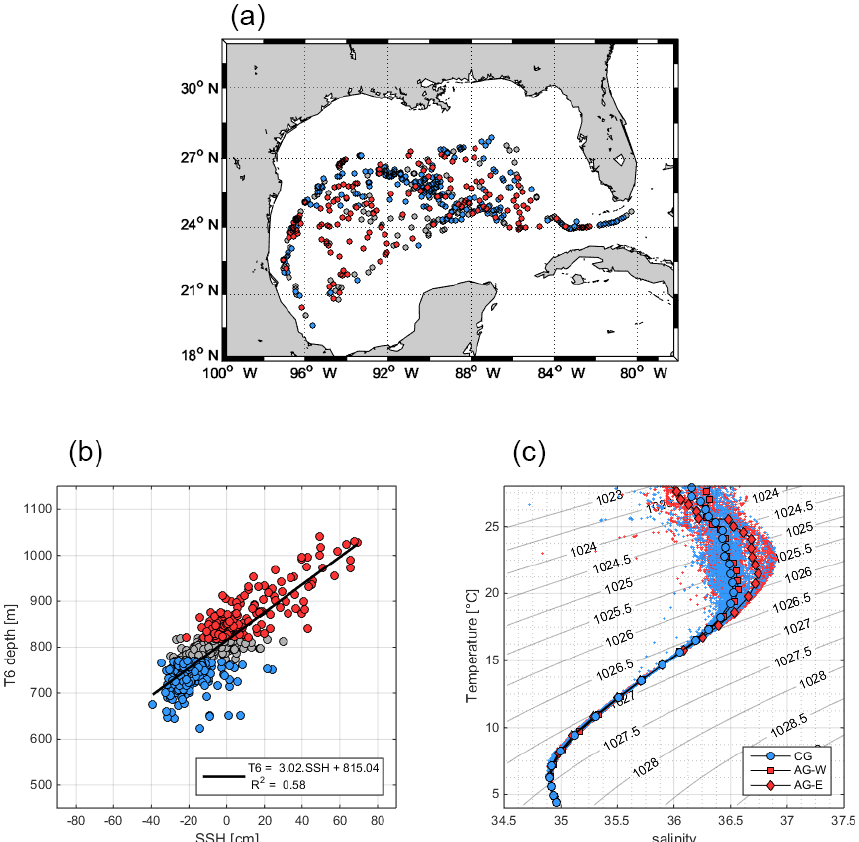
Figure 2. (a) Position of float profiles. Depth of the 6 ◦ C isotherm derived cyclones and anticyclones are given by blue and red circles respectively. (b) Depth of the 6 ◦ C isotherm versus SSH (gridded data with a spatial resolution of 1/8 ◦ , produced by Ssalto/Duacs and distributed by AVISO, with support from CNES (http://www.aviso.altimetry.fr/duacs). To remove seasonal steric effects of large-scale heating and cooling of the upper water column, daily mean SSH calculated in the Gulf of Mexico were systematically subtracted from SSH values. Blue points correspond to the cyclonic group, and red points to the anticyclonic group. (c) T/S diagram. Cyclones are identified in blue (blue circles are mean values) and anticyclones in red (red squares are profiles acquired at a latitude west of − 88 ◦ (west GOM) and red diamonds are profiles acquired at a latitude east of − 88 ◦ (east